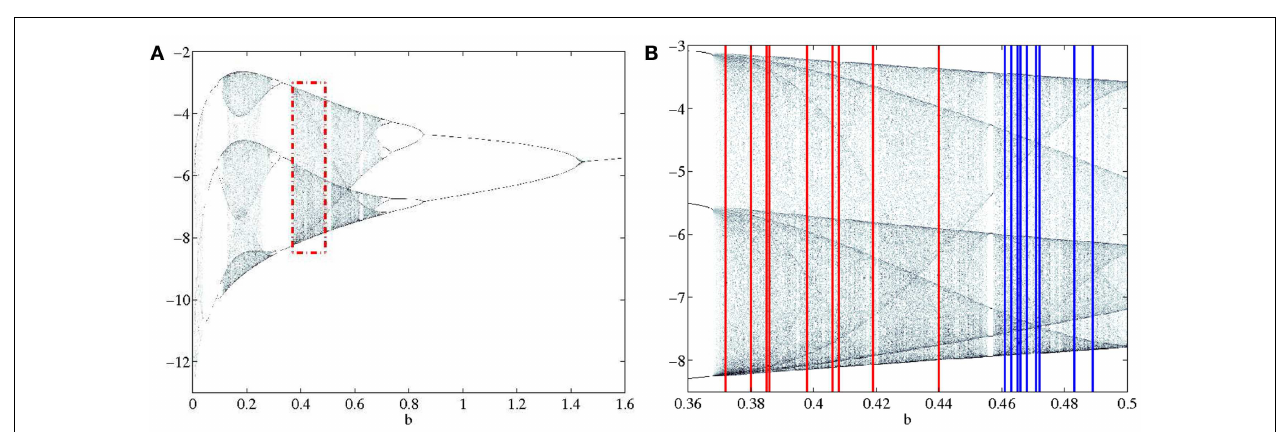
FIGURE 1 | Long term behavior of chaotic ( b = 0.45) and simple ( b = 1.0) attractors (top panel) . Embeddings of x ( t ) in xx τ -plane that are used to generate Poincaré sections (middle panel).The intersections of the embedded time series with the line x τ = 0 are marked with yellow